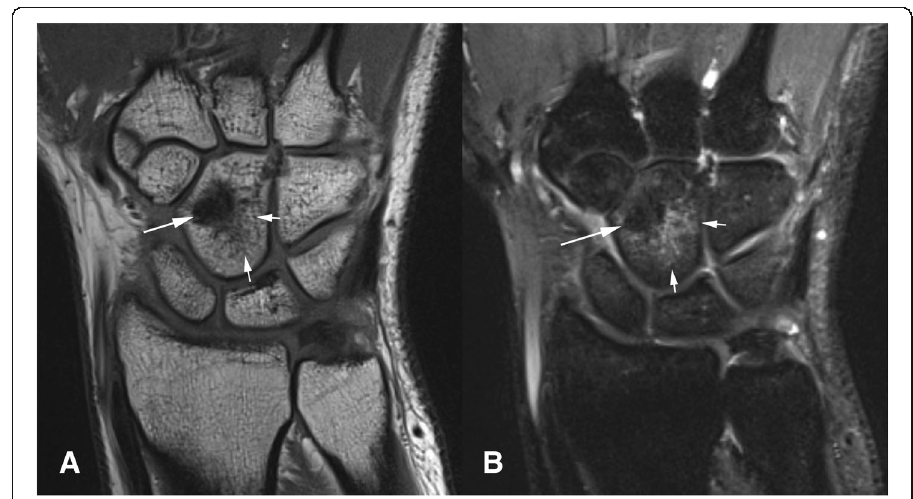
Fig. 1 MR images in a patient 4 days after carpal trauma at the same day with bone bruise (short arrows) in the capitate and a bone island (long arrow). Coronal T1 ( a ). Coronal STIR ( b )